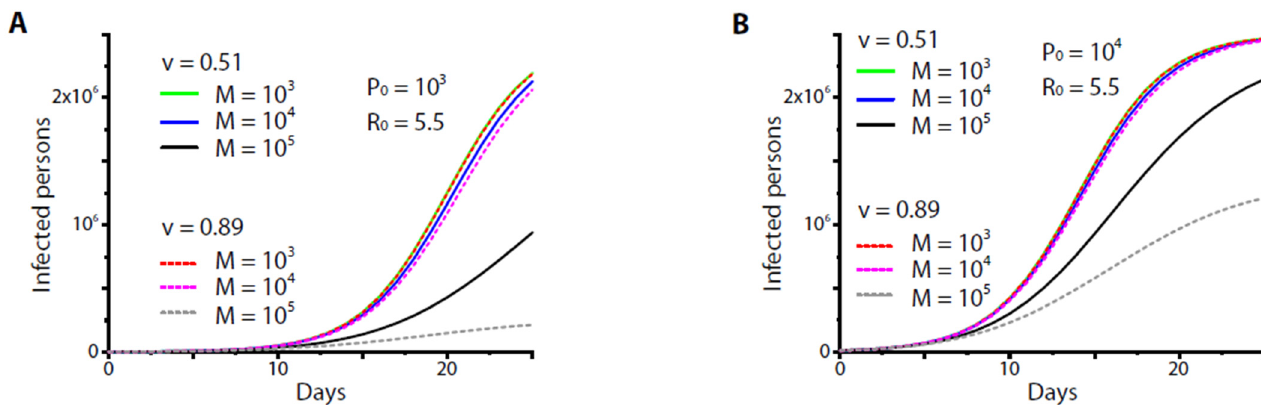
Figure 1. The numerical results from Equation (5) for two different initial carrier numbers P 0 (=10 3 in ( A ) and 10 4 in ( B )) and various vaccination rates to yield M fully vaccinated persons/day. Note that curves at M = 10 3 –10 4 persons/day were almost overlapped regardless of the initial condition and vaccine effectiveness. A significant reduction of infected persons occurred only if M = 10 5 persons/day (black and grey lines). For all the results, the average infectious period T i was set as 14 days, the number of entire population N was set as 2.5 × 10 6 , and the basic reproduction number R 0 was set as 5.5. v = 0.51 or 0.89 was the effectiveness of the vaccine.